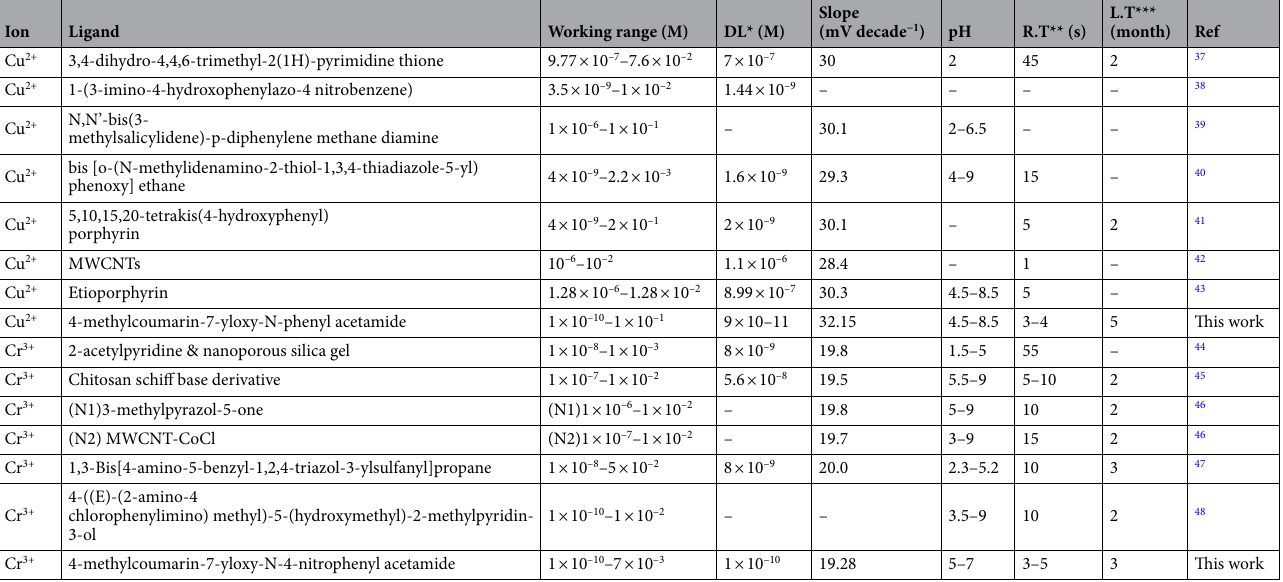
Table 6. Comparison between the suggested CPEs and the formerly similar reported copper (II) and chromium (III) selective electrodes in literature. *Detection Limit, ** Response Time, *** Life